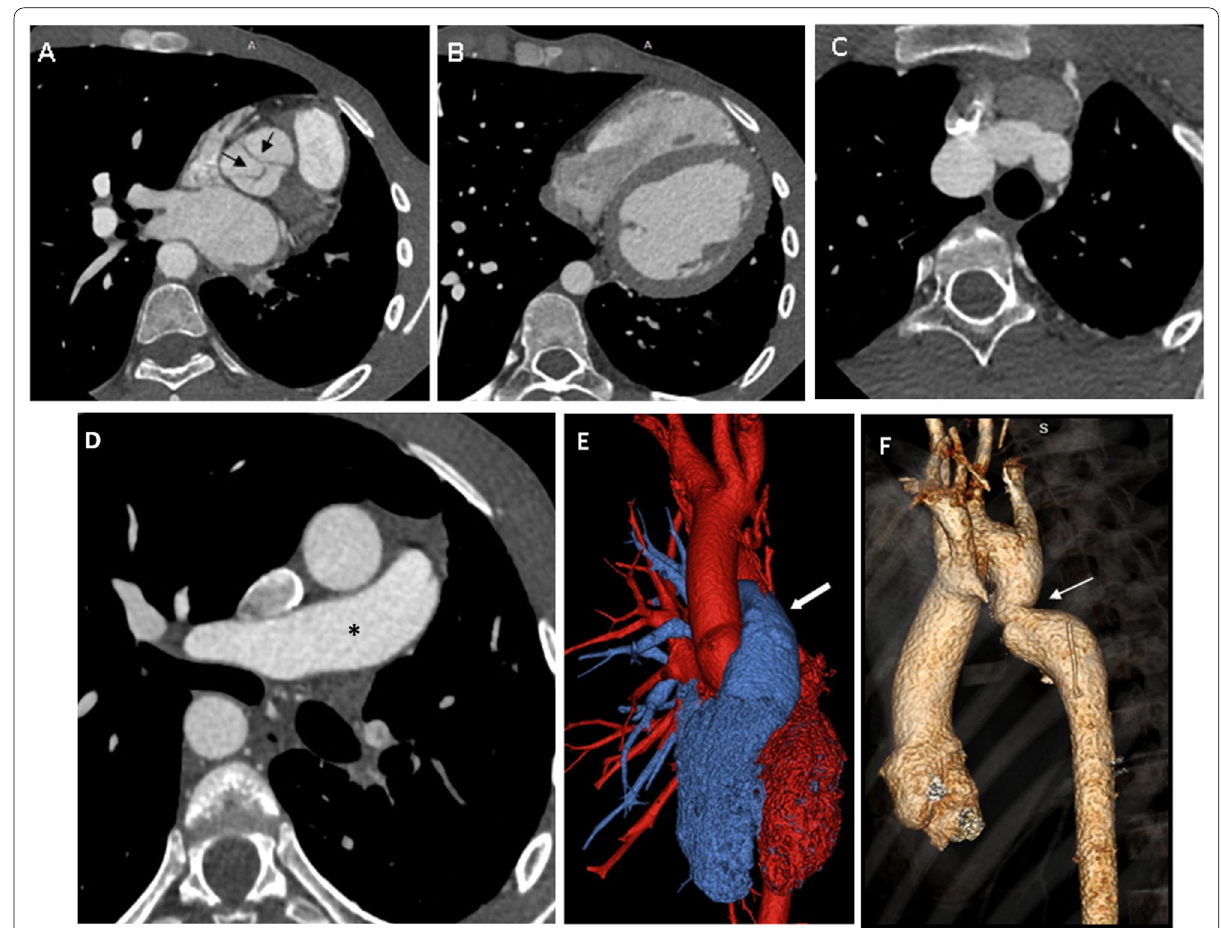
Fig. 7 A 17-year-old male axial CT images revealed. A Bicuspid aortic valve (arrows). B LV hypertrophy. C Right sided aortic arch. D MPA (*) with absent LPA. E , F 3D Volume rendered images showing E) absent LPA (block arrow in E ). F Coarctation of the aorta (arrow in F) distal to Lt